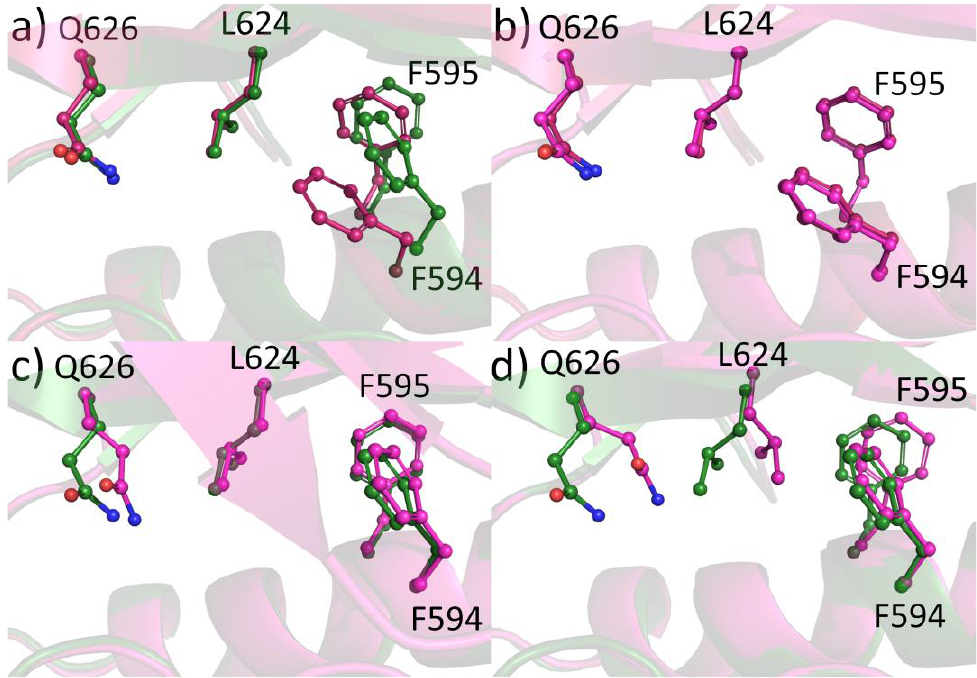
Figure 5. Differences induced by compound binding to the conformation of Phe594 and Phe595. ( a ) Comparison of JAK2 JH2 WT (PDB code 4FVQ, green) and JAK2 JH2 V617F (PDB code 4FVR, pink). ( b ) Comparison of JAK2 JH2 V617F- 24 (magenta) and JAK2 JH2 V617F (pink). ( c ) Comparison of JAK2 JH2 V617F- 6 (magenta) and JAK2 JH2 WT (green). ( d ) Comparison of JAK2 JH2 V617F- 16 (magenta) and JAK2 JH2 WT